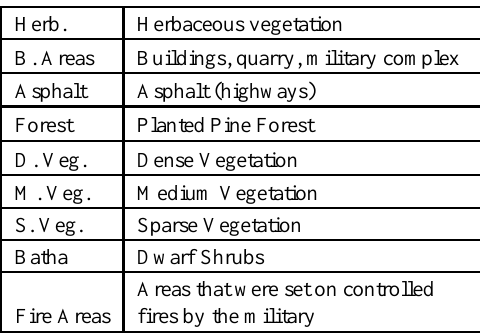
Table 3: Description of the land-cover